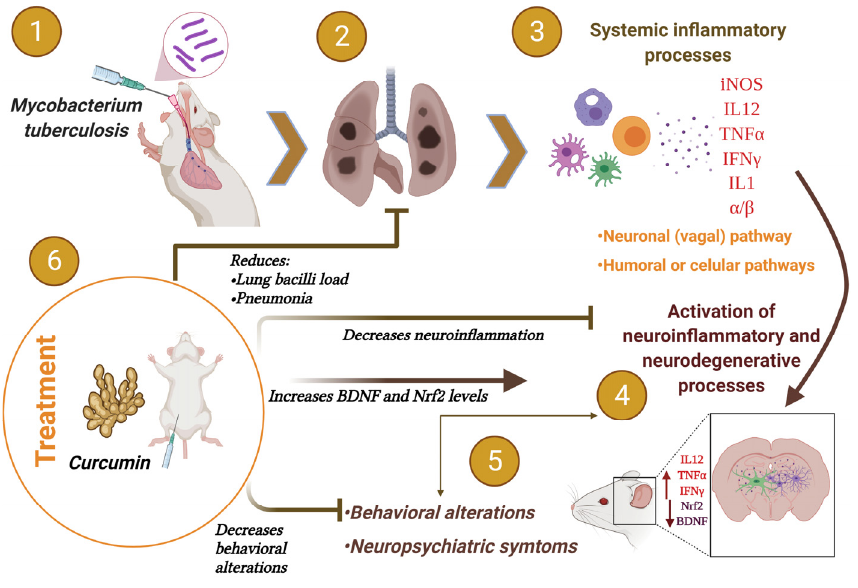
Figure 12. In a mouse model of pulmonary TB, curcumin (CUR) treatment slightly increased Nrf2 and BDNF levels, reduced neuroinflammation, behavioral and neuropsychiatric symptoms as well as lung disease. (1) Intratracheal lung infection with Mtb (2) produced the development of active disease in the mice. (3) Intense inflammation in the lungs caused by an immunological response to mycobacteria promotes neuroinflammation via humoral and neuronal pathways, (4) characterized by increased production of various cytokines (5), and decreased Nrf2 and BDNF levels, which lead to behavioral changes and neuropsychiatric symptoms such as depression and anxiety. (6) Due to the anti-inflammatory, antioxidant and antibacterial actions of CUR, the treatment decreased lung disease and cytokine generation in the brain, slightly increased Nrf2 levels in the frontal cortex and hippocampus and increased BDNF levels in the hippocampus. All these changes reduced the behavioral abnormalities in the TB animals. Therefore, CUR might be used as a coadjuvant treatment in TB chemotherapy. Created with BioRender.com (accessed on 20 January 2022).